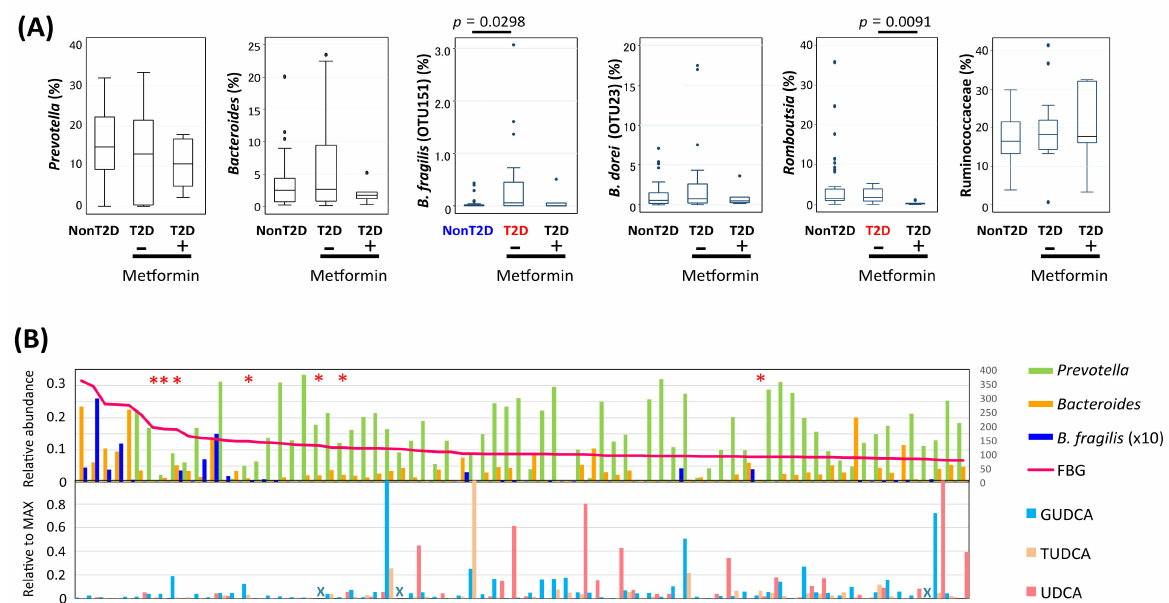
Figure 6. Distribution of the key bacteria and anti-diabetic UDCAs among Indonesian subjects. ( A ) Comparison of abundance of the key taxa among non-T2D, metformin-treated T2D, and non-treated T2D groups. ( B ) Relative abundance of genera Prevotella , Bacteroides and B. fragilis (upper graph) and GUDCA, TUDCA, and UDCA (lower graph) in 75 Indonesian subjects ordered by the FBG level. Red line indicates FBG. Red asterisks above the graph indicate subjects administered metformin. Blue crosses in the bottom graph indicate the samples lacking in the bile acid